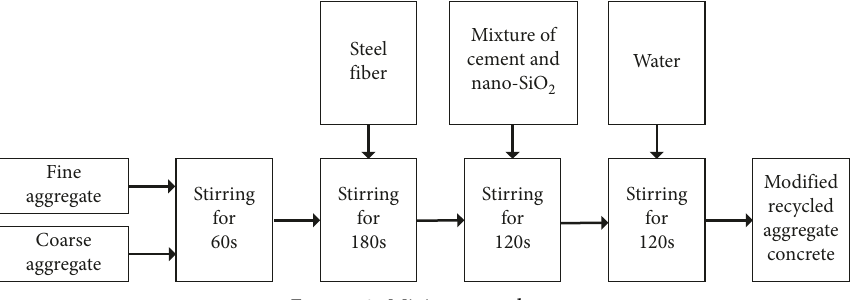
Figure 2: Mixing procedure.